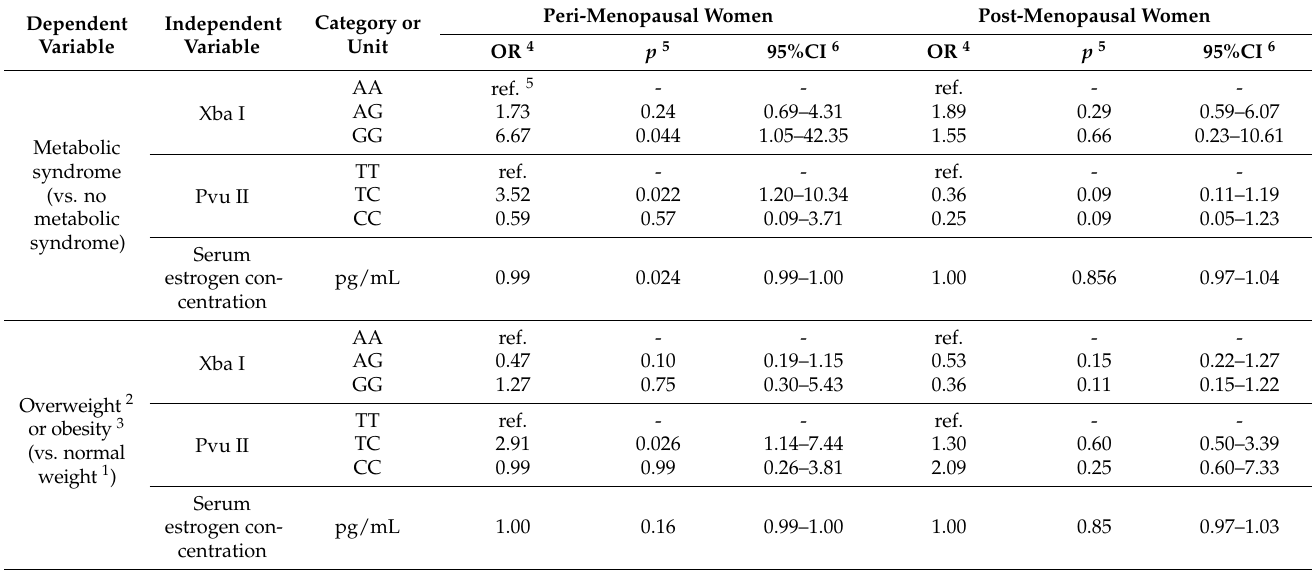
Table 5. Logistic regression models for metabolic syndrome, and overweight or obesity against polymorphism of estrogen receptor alpha: Xba I and Pvu II, and serum estrogen concentration in peri- and post-menopausal